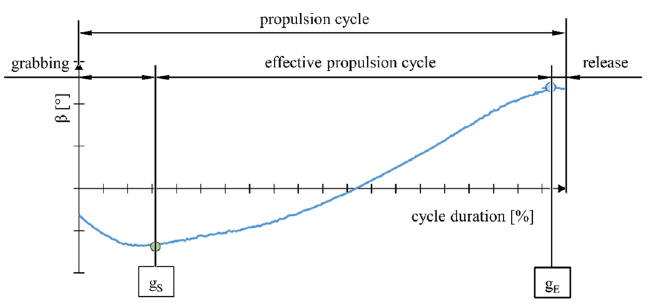
Figure 7. Graph representing angular position of the hand relative to the vertical axis as a function of the percentage share of the total propulsion cycle, with individual stages of the propulsion cycle identified, where: g S —push-rim gripping point, g E —push-rim release